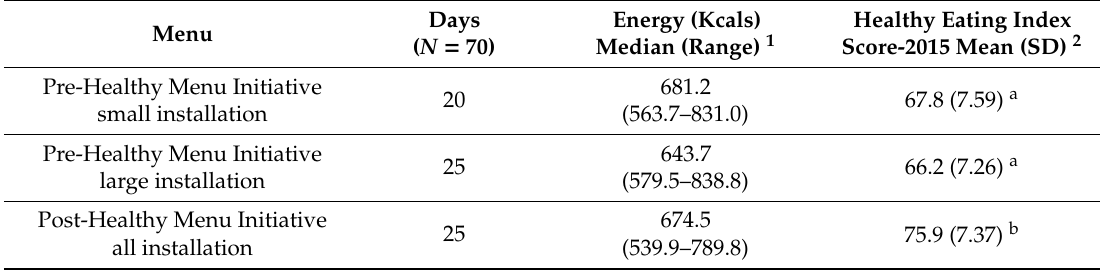
Table 1. Energy and Healthy Eating Index-2015 scores for pre- and post-Healthy Menu Initiative